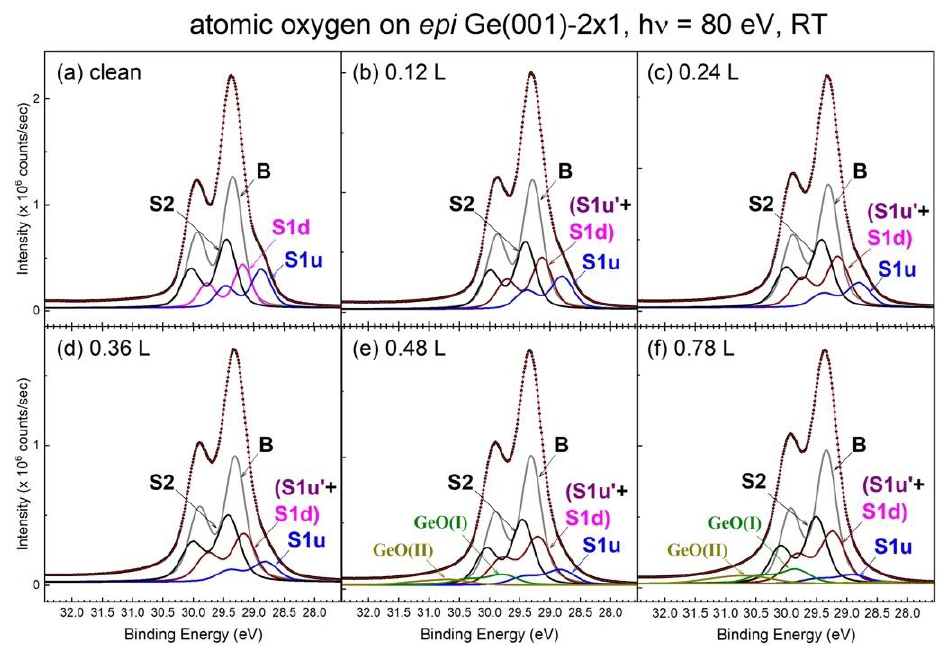
Figure 6. A fit to the representative Ge 3d core core-level spectra in Figure 5 emphasizing the initially low atomic-O coverages.